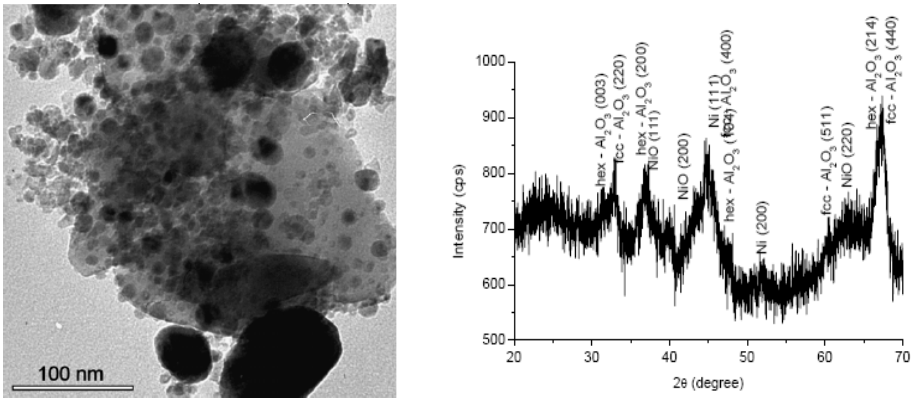
Figure 4. TEM and XRD images of the commercial model catalyst 20.7 wt% Ni/Al HTC-500. The average particle size was found to be about twice as much as for the self-made Ni-catalyst and showed considerably broad size